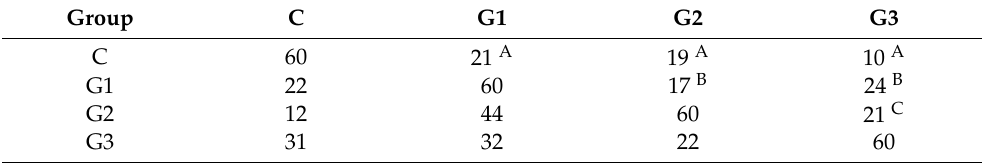
Table 3. The number of mRNAs that were differentially expressed in endometrial tissue samples. Group C G1 G2 G3 C